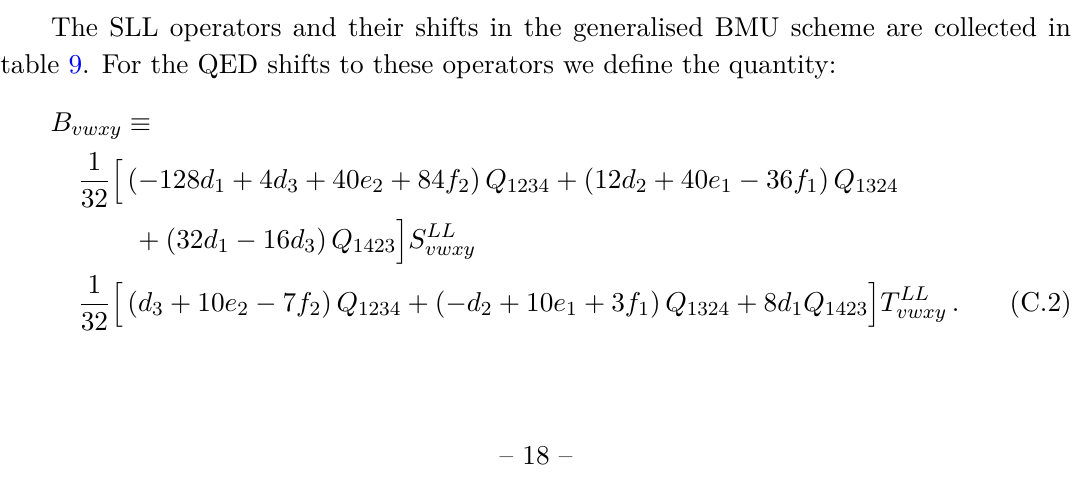
Table 8. Fierz transformations for scalar P L ⊗ P R operators together with their one-loop QCD and QED shifts in the generalised BMU